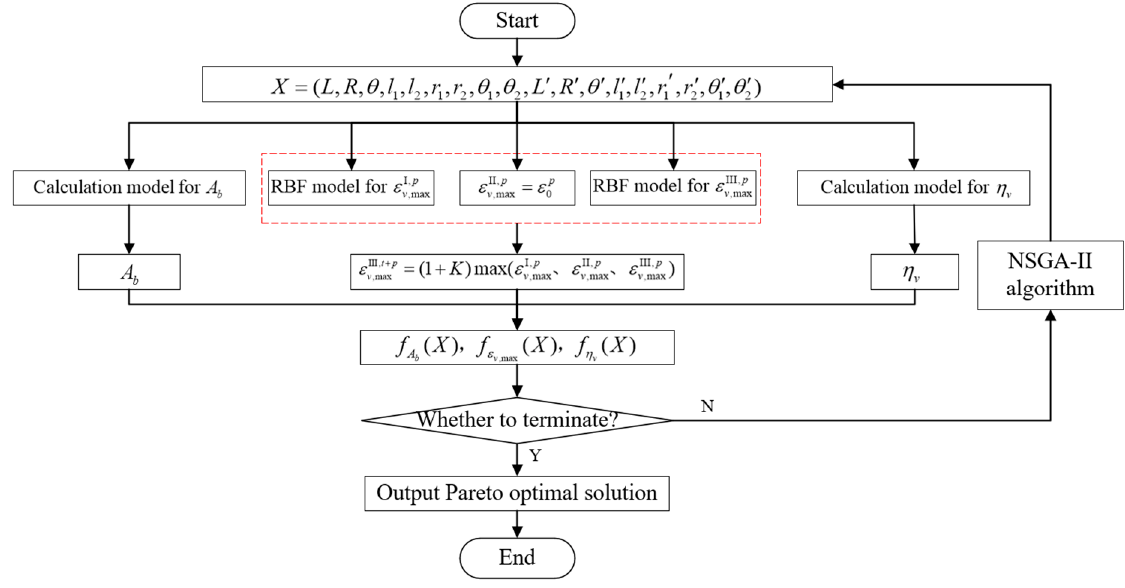
Figure 14. Flowchart for solving the multiobjective optimization problem of grain.